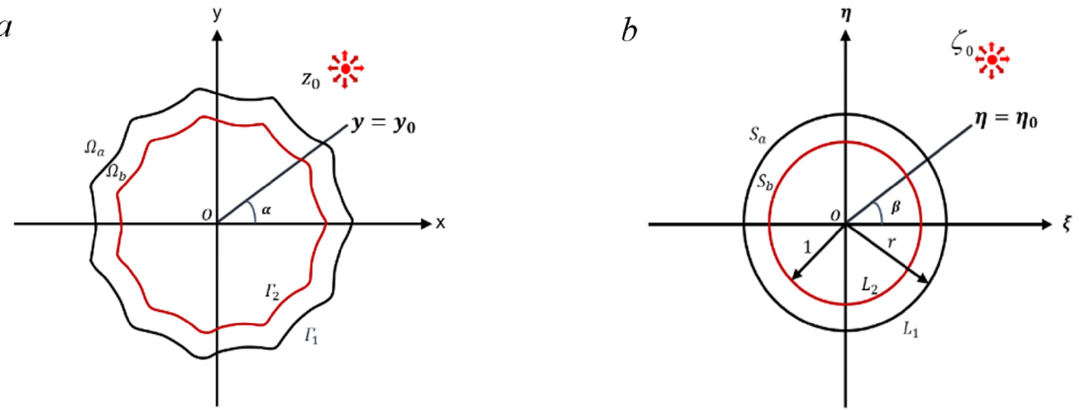
Figure 2. The ( a ) physical plane ( z -plane) and ( b ) mathematical plane ( ζ -plane) of a polygonal coated hole under thermal singularity.